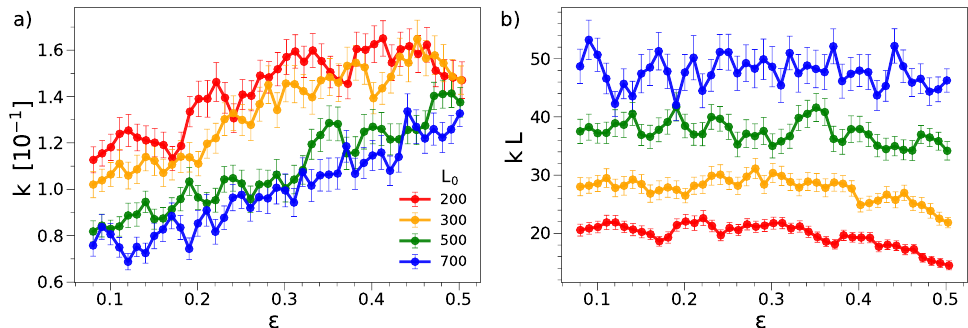
Figure 4. Dependence of the wavenumber ( a ) and reduced wavenumber ( b ) upon compression. The wavenumbers are in units of σ − 1 ; see Section